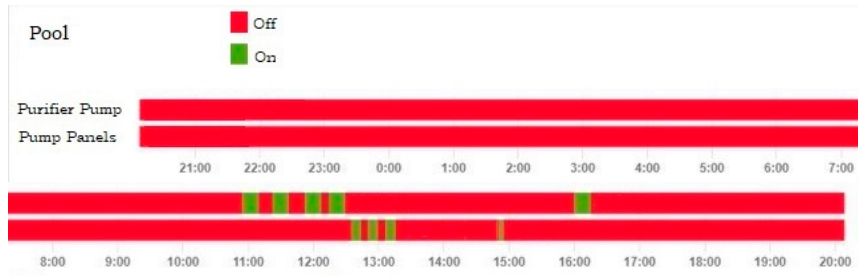
Figure 8. Pump panels pump and purifier pump start-up time for scenario 3. Table 3. Daily energy consumption and economic cost of each process in scenario 2. Table 5. Daily energy consumption and economic cost of each process in scenario 3.